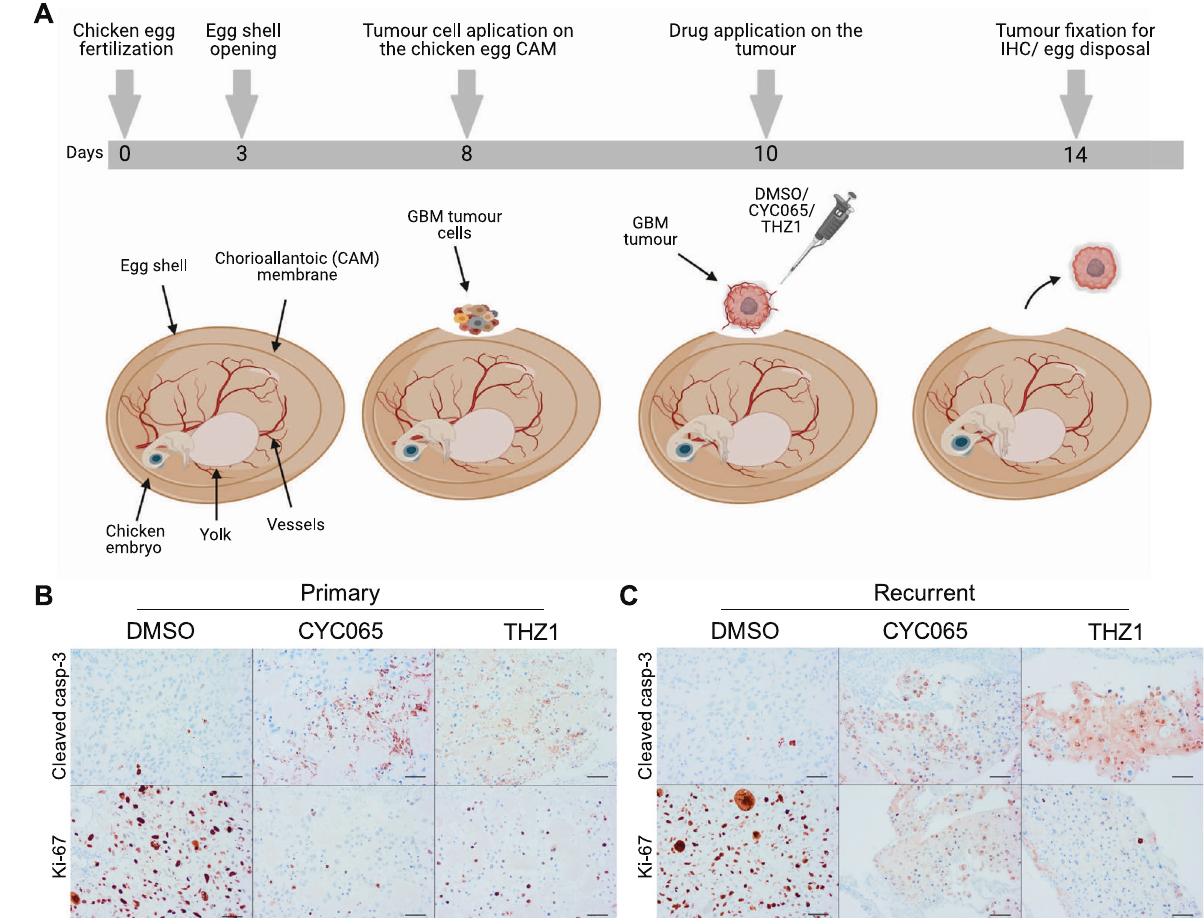
(CAM) of the chicken eggs (day 8 after egg fertilisation) and on day 10 treated with DMSO (control) or 3 µM CYC065 and 100 nM THZ1 for 4 days. On day 14 tumours were resected and fi xed in PFA for immunohistochemical analysis. B Representative images of immunohistochemical staining for cleaved caspase-3 and Ki67 in the harvested tumours from the primary semi-in vivo chick embryo xenograft model established using N16-0240 cells and treated with DMSO, CYC065, or THZ1. Three tumours were collected per group. Scale bar = 50 µm. C Representative images of immunohistochemical staining for cleaved caspase-3 and Ki67 in the harvested tumours from the recurrent semi-in vivo chick embryo xenograft model established using GTCC-9 cells and treated with DMSO, CYC065 or THZ1. Three tumours were collected per group. Scale bar = 50